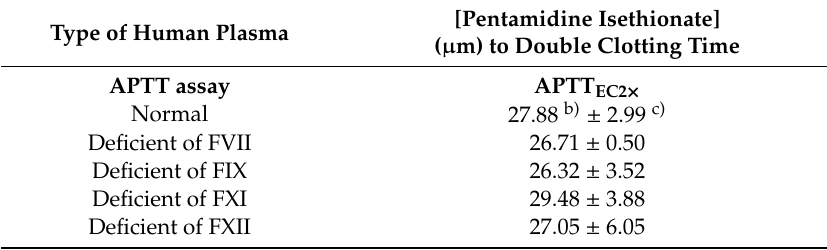
Figure 2. Effect of pentamidine isethionate on the clotting times of APTT, PT, and TT in normal human plasma. Shown is the prolongation of clotting time as a function of pentamidine isethionate concentration (0–120 μ M) in either APTT assay ( ■ ), PT assay ( ◊ ), or TT assay ( ● ). Solid lines are trend lines from which the concentration necessary to double the clotting time was deduced. Given also are the standard error bars (±1 SE). Penta. Ise.= Pentamidine isethionate. Table 1. The effect of pentamidine isethionate on the clotting times (APTT, PT, and TT) of different human plasmas. a)